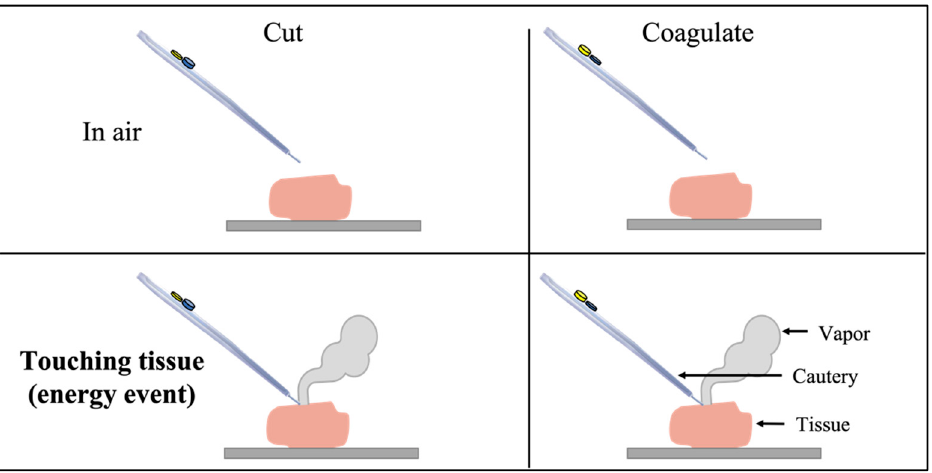
Figure 2. Cautery states in “on” mode, which need to be controlled differently depending on the outcome of the mass spectrometry.